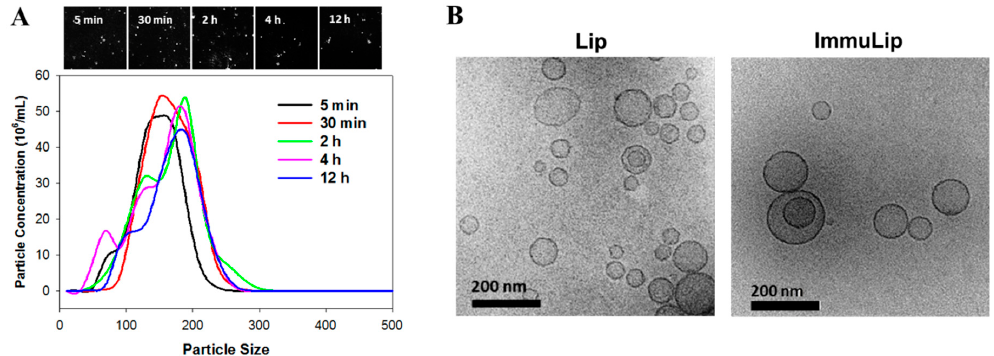
Figure 2. ( A ) The stability of CPT-11 and panobinostat-loaded immunoliposomes (ImmuLipCP) in 10% fetal bovine serum (FBS)/90% phosphate buffered saline (PBS) solution as determined by nanoparticle tracking analysis (NTA) with the screenshot images showing the light scattering particles. ( B ) The morphology of liposomes (Lip) and immunoliposomes (ImmuLip) from cryo-transmission electron microscopy (cryo-TEM) analysis (Bar = 200 nm).